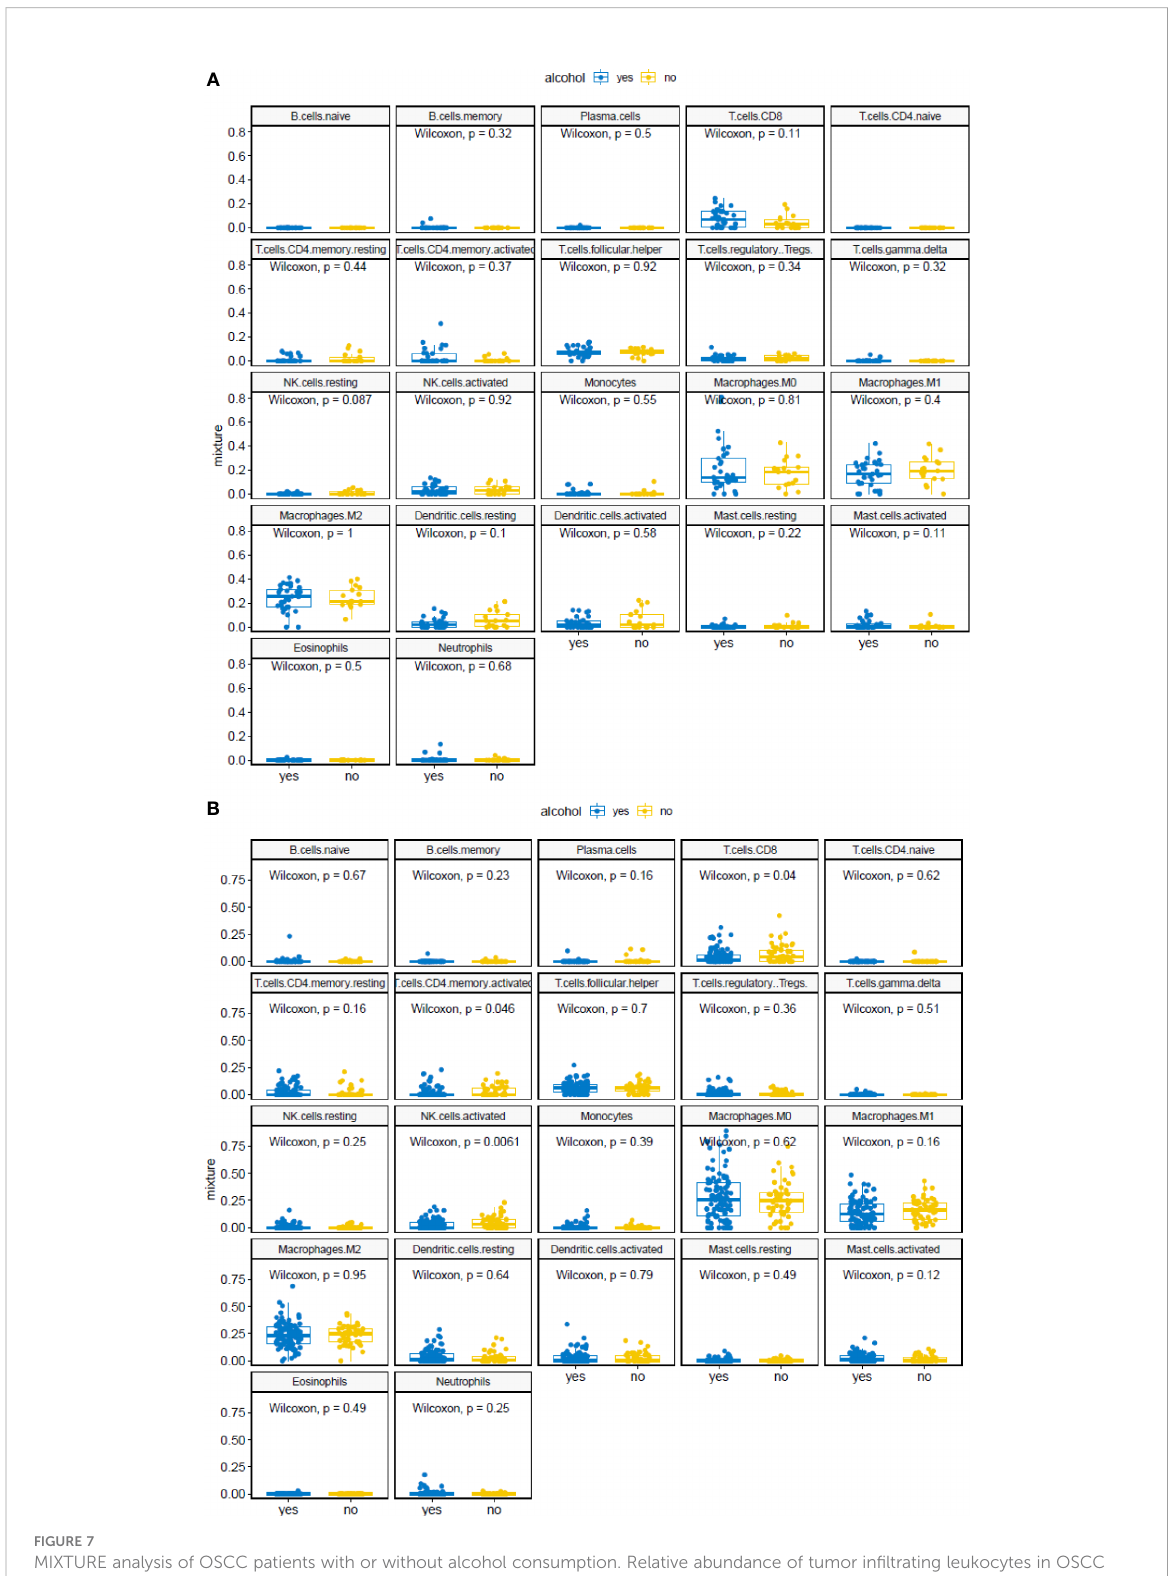
FIGURE 7 MIXTURE analysis of OSCC patients with or without alcohol consumption. Relative abundance of tumor in fi ltrating leukocytes in OSCC from patients with or without alcohol consumption, classi fi ed according to their tumor stages. Stages I-II (A) or III-IV (B) . Wilcoxon signed- rank test was